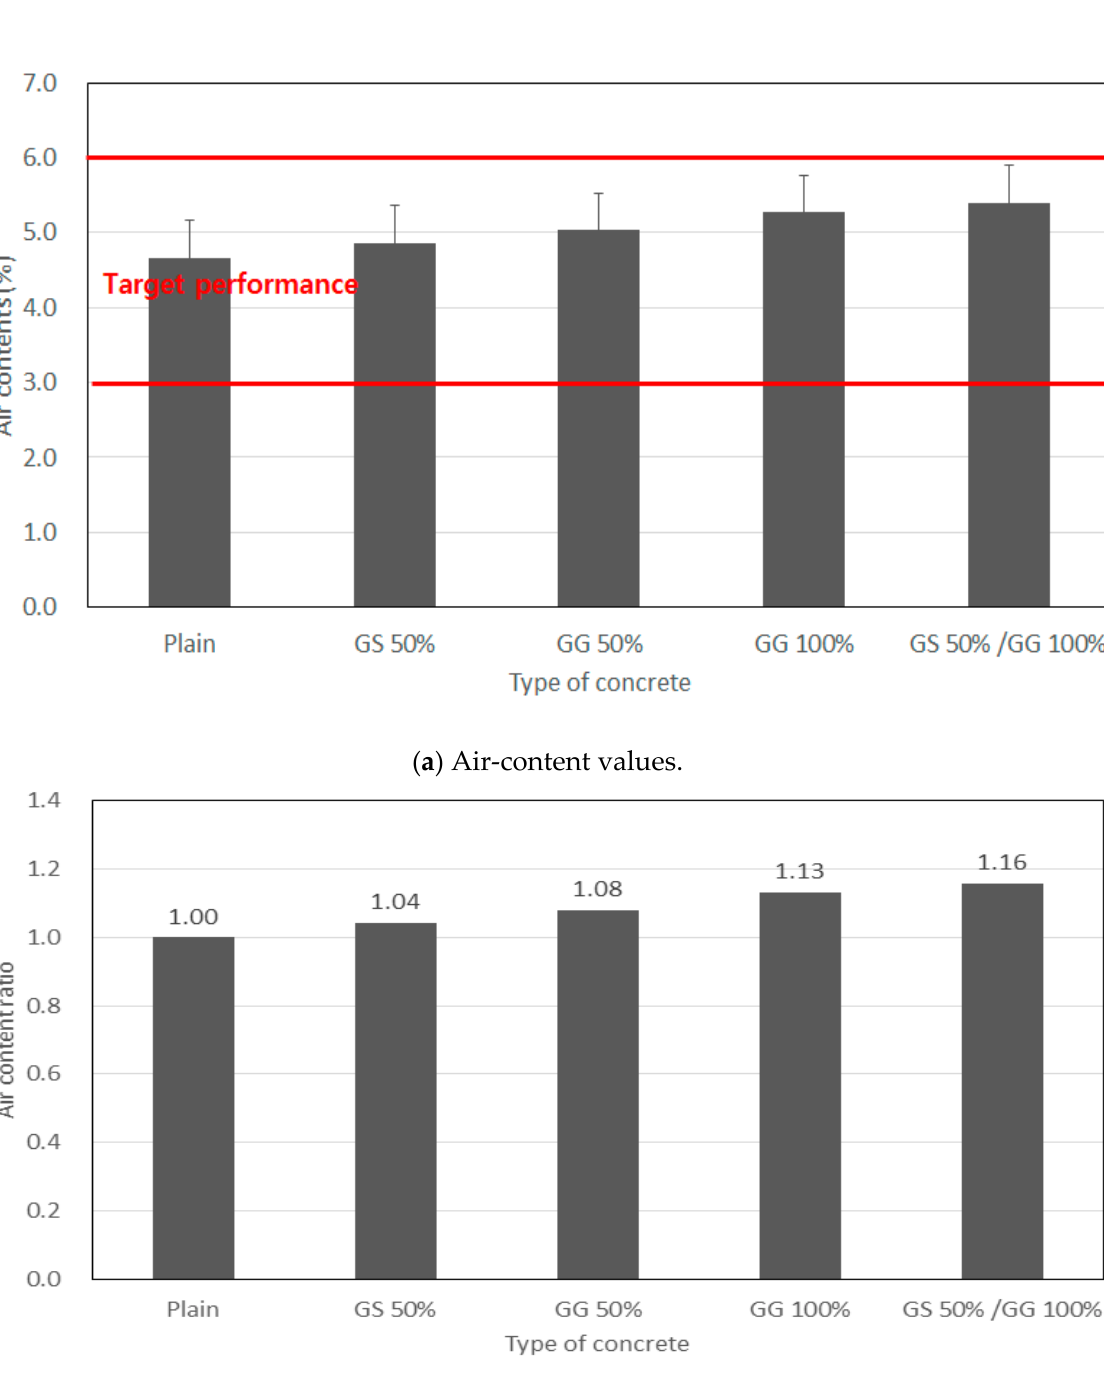
Figure 2. Slump test results.